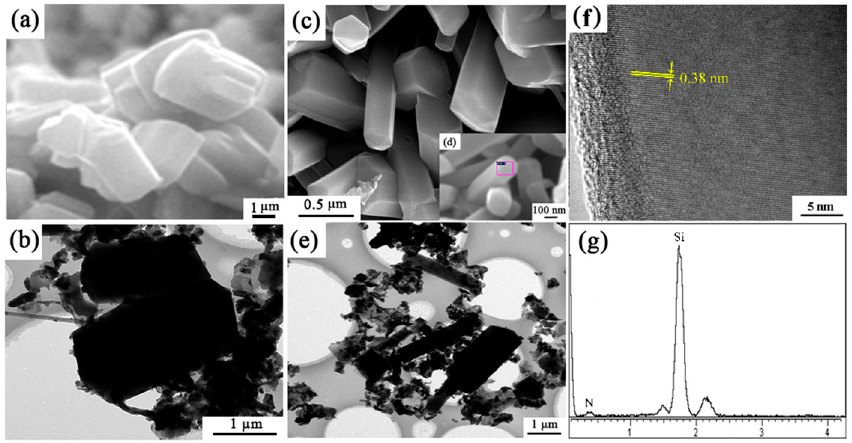
Figure 11. SEM, TEM/HRTEM images and EDS patterns of ( a , b ) sample S1 and ( c – g ) S6 nitrided at 1600 °C for 3 h.